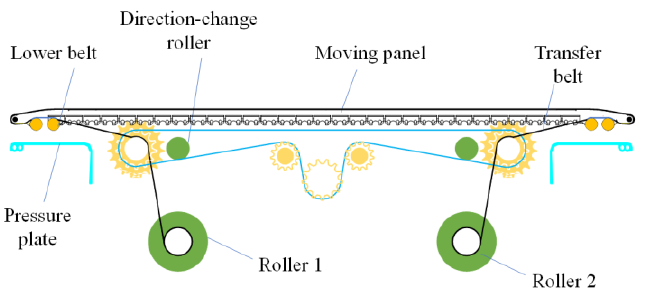
Figure 5. Transmission mechanism diagram of the moving panel and the transfer belt.